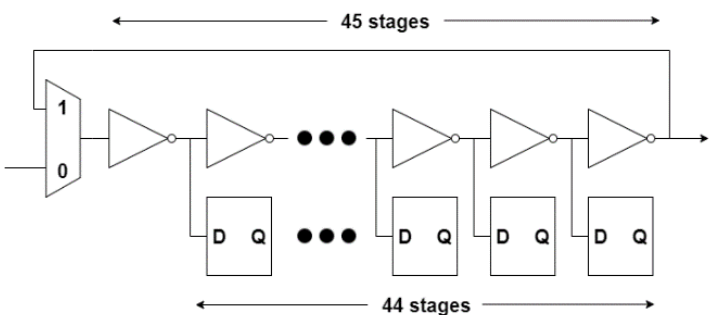
Figure 9. Schematic of the 28-nm RO design.